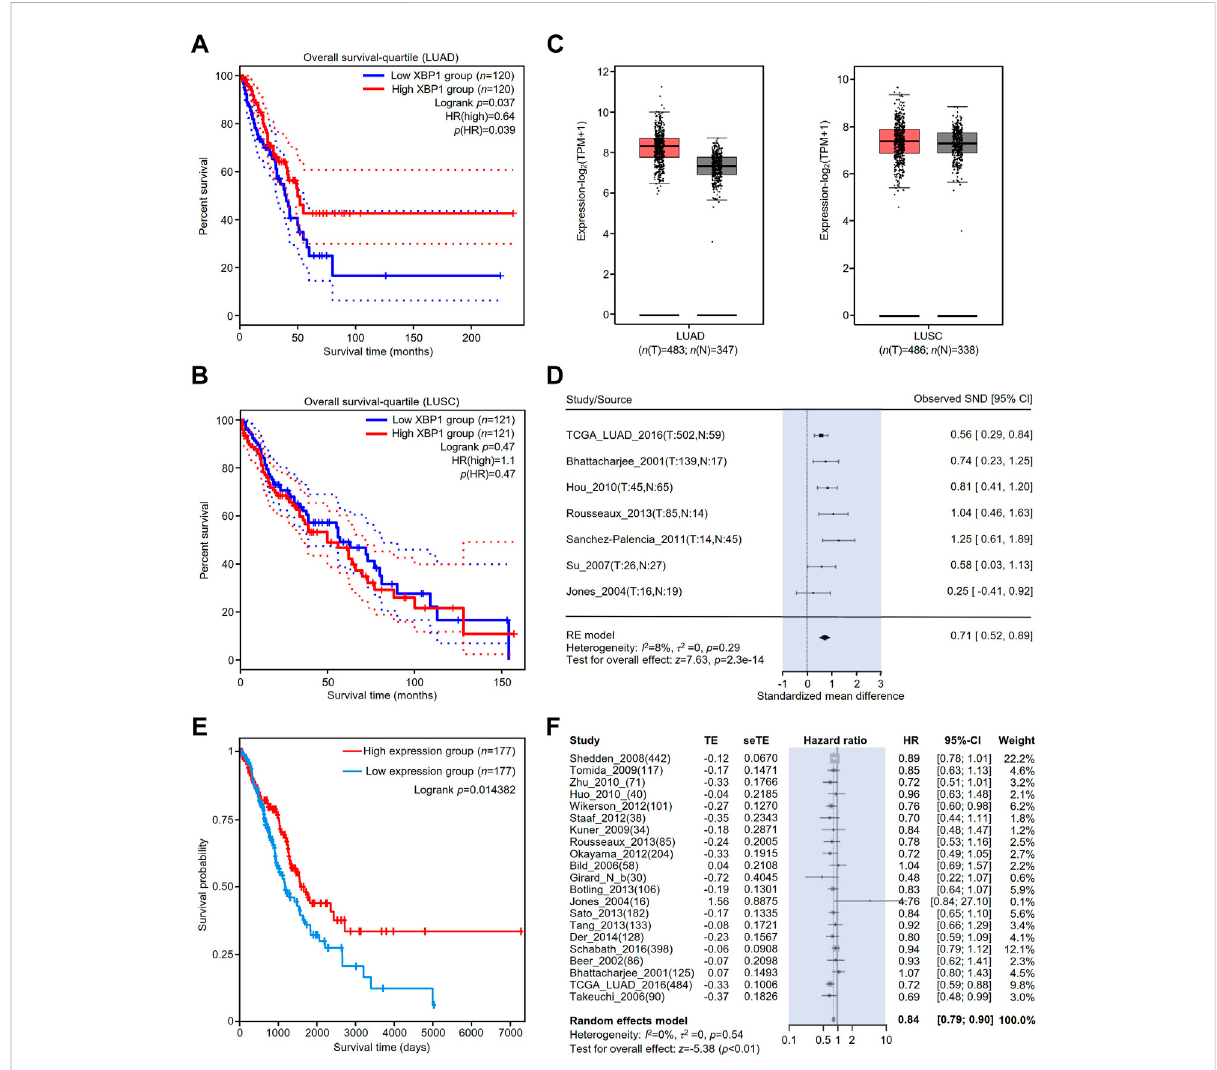
FIGURE 2 The prognostic value of XBP1 expressing in the lung tissues of patients with LUAD or LUSC. (A,B) The prognostic value of XBP1 mRNA level expressing in LUAD and LUSC patients was evaluated by GEPIA2. (C) Expressional boxplot of XBP1 in LUAD and LUSC based on GEPIA2. (D,E) The favorable prognosis of XBP1 overexpression in LUAD was veri fi ed by TCPA (D) and Lung Cancer Explorer database (E) . (F) Meta-analysis of XBP1 expression in LUAD from the Lung Cancer Explorer